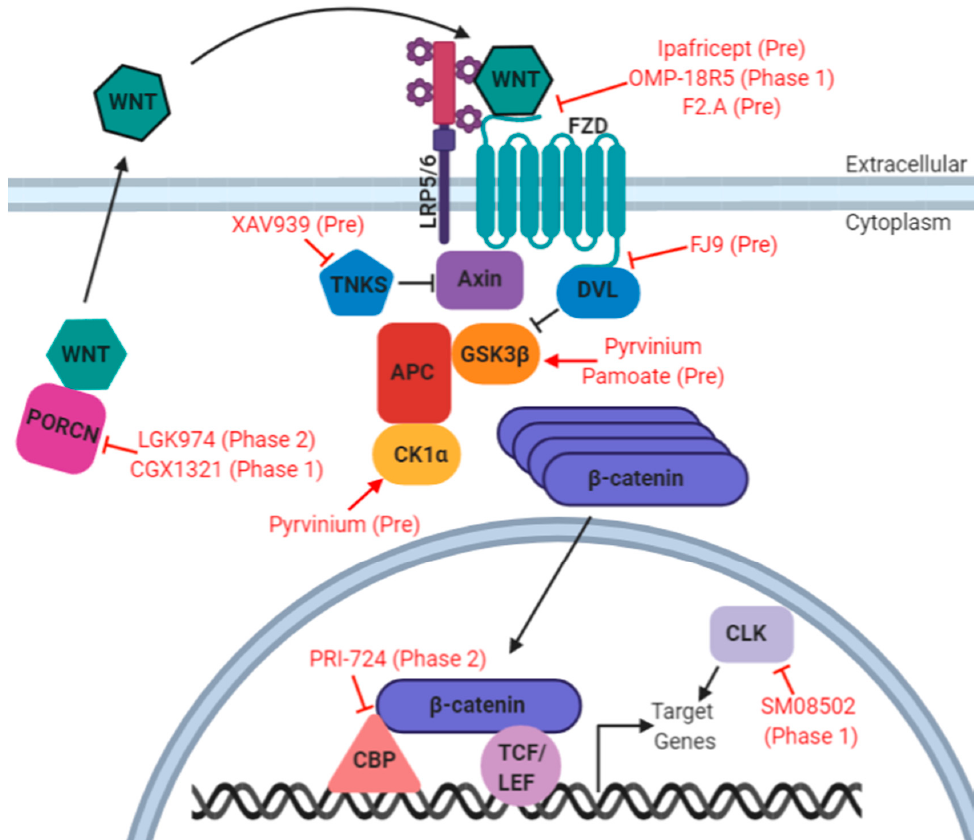
Figure 1. Therapeutic Targeting of the Wnt Signaling Pathway. Red letters = drug/compound name. Pre = pre-clinical development, Phase # = clinical trial phase. Clinical trial not necessarily for gynecologic malignancy. Figure generated with